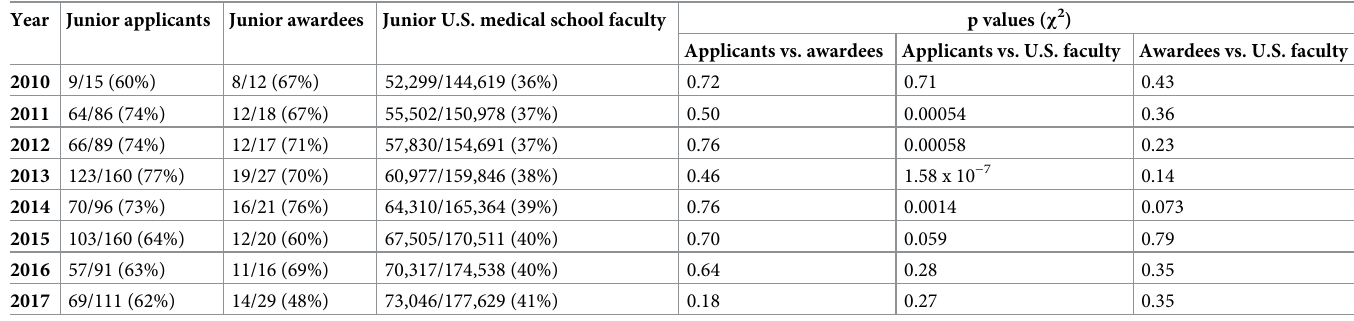
Table 3. Comparison of proportion of BRI grant applicants, BRI grant awardees, and U.S. medical school faculty at junior academic rank by year,